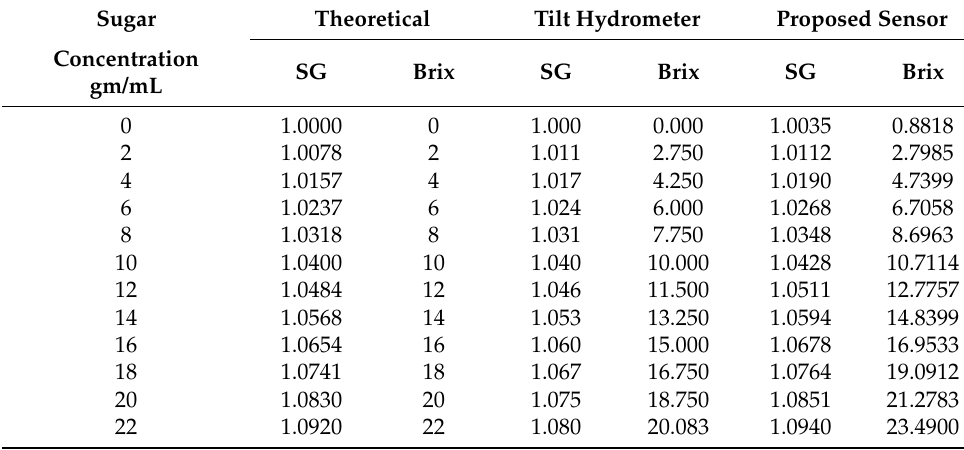
Table 5. SG and Brix values of the proposed sensor and Tilt